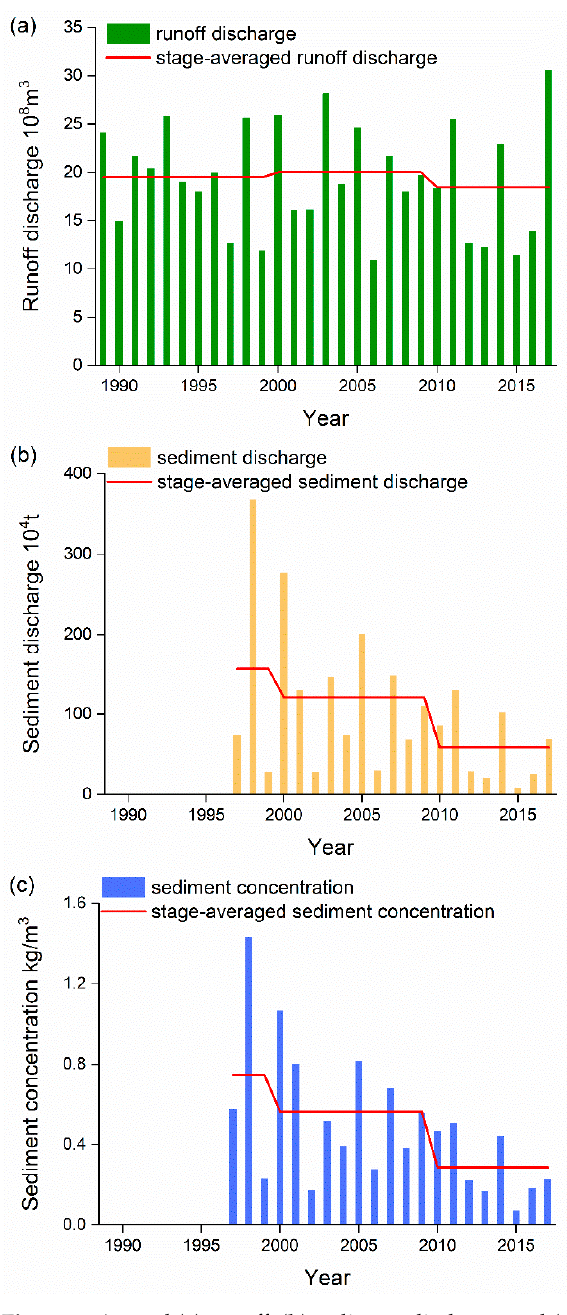
Figure 7. Annual ( a ) runoff, ( b ) sediment discharge and ( c ) suspended sediment concentration in the Daning River basin.